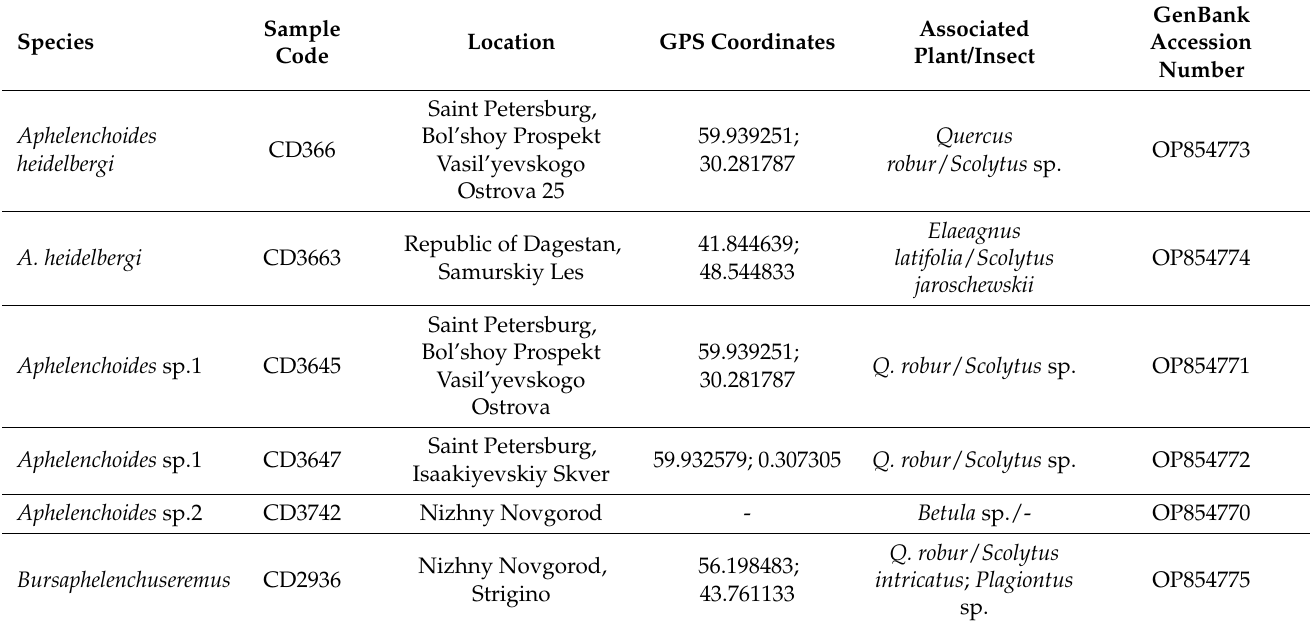
Table 1. Species and populations of nematodes from Russia and Belarus characterized in the present